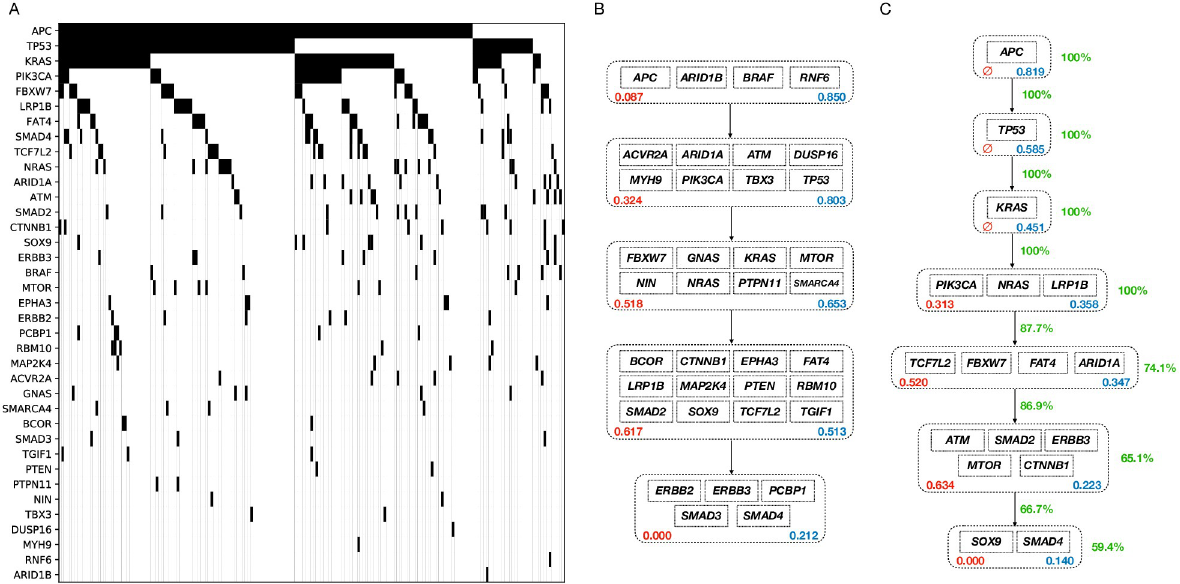
Fig 7. The COADREAD dataset analysis. A: The dataset representation. The genes are sorted based on their mutation frequencies. B: ILP-based method inferred model. C: Our MCMC method inferred model.